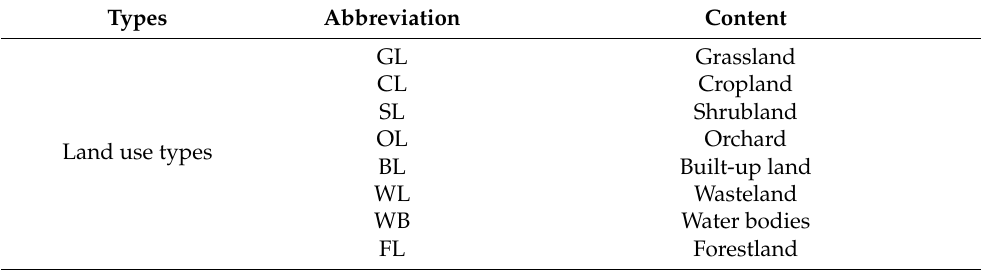
Table A1. Land use types, landscape metrics and other factors